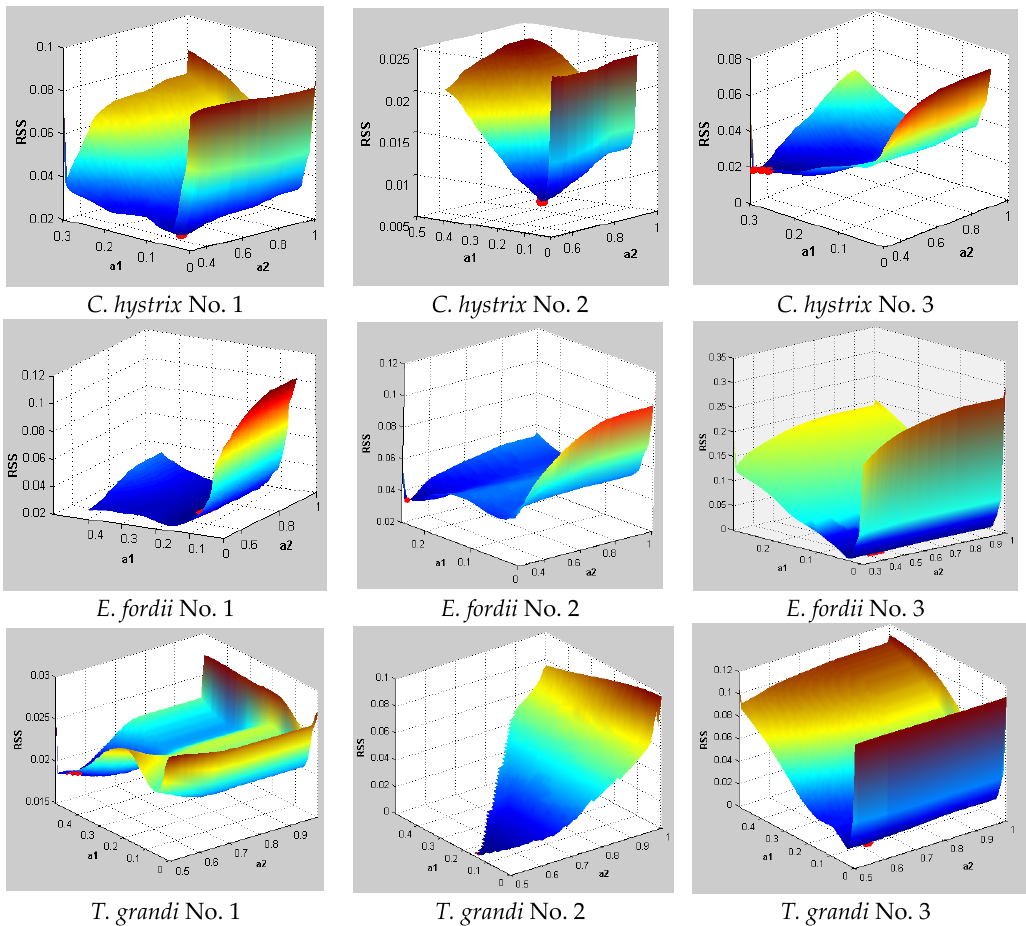
0 1      ) of 1 2    calculated 1 2